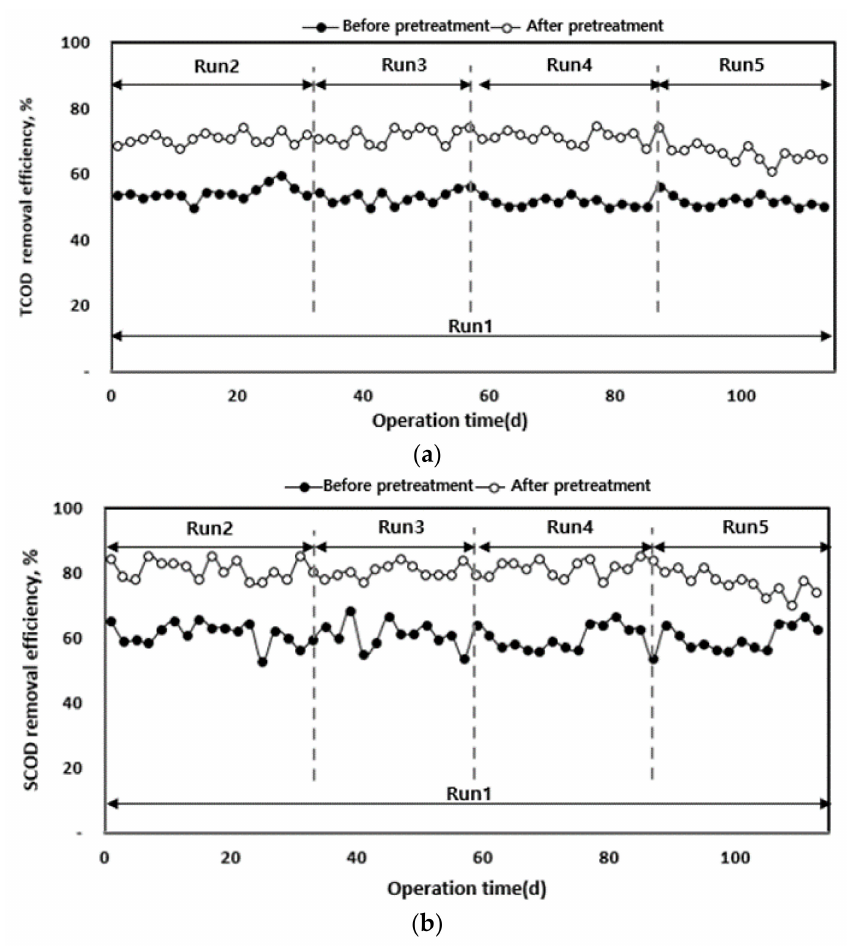
Figure 6. TCOD ( a ) and SCOD ( b ) removal e ffi ciency according to operation